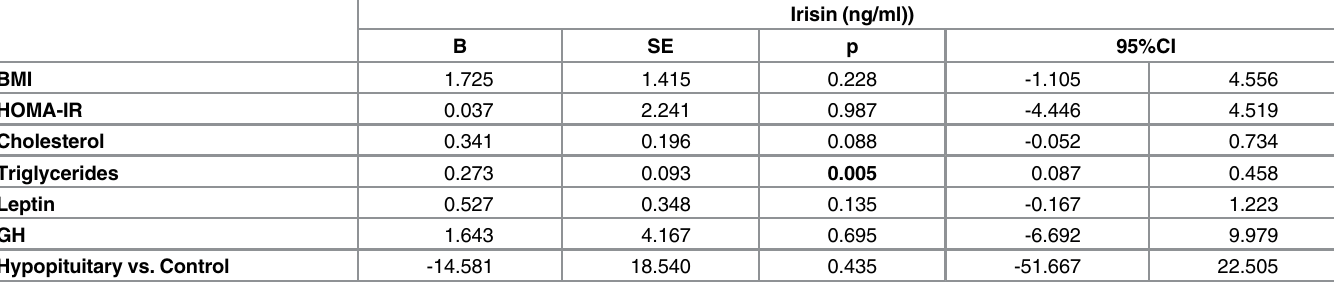
Table 4. Multivariate analysis of variables related to Irisin values: linear regression